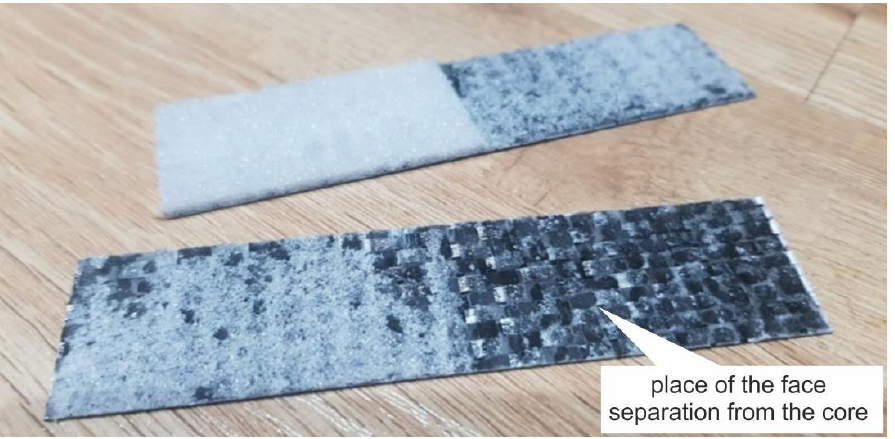
Figure 16. Destroyed sample during an adhesion test between the core and the faces of Airex core composite.